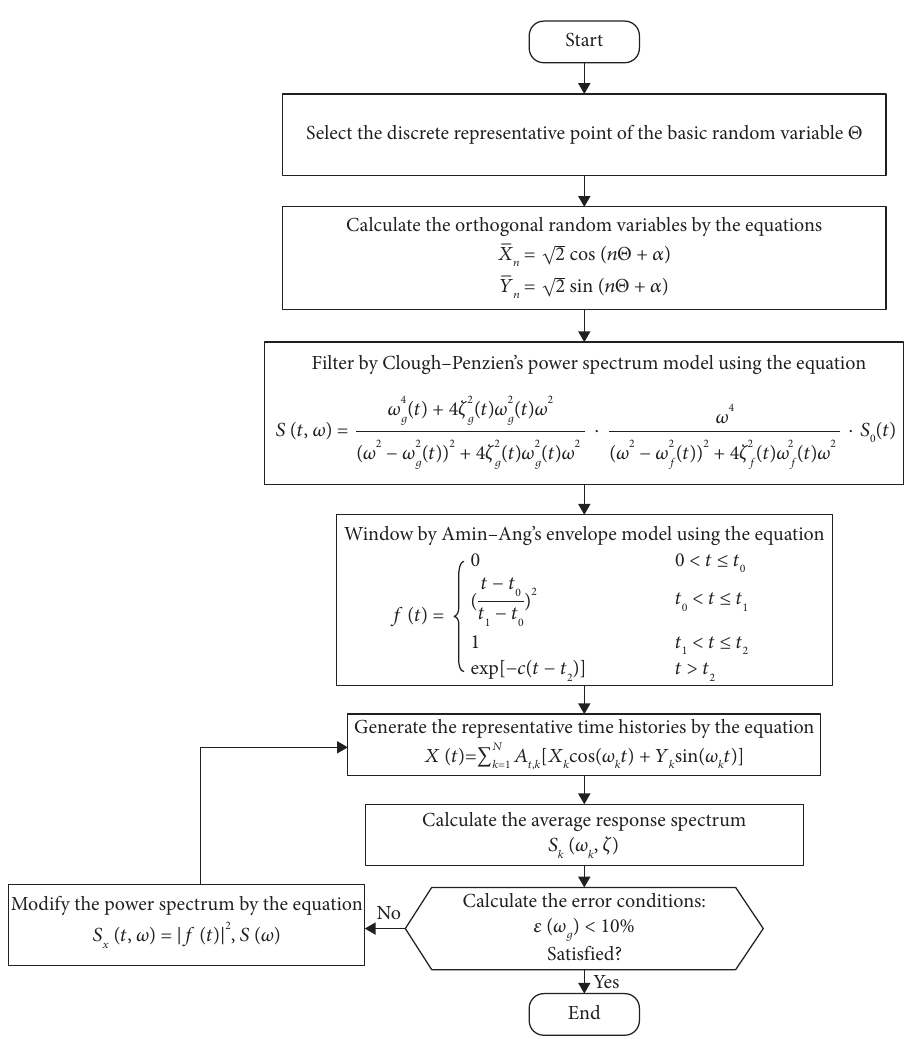
Figure 2: Target response